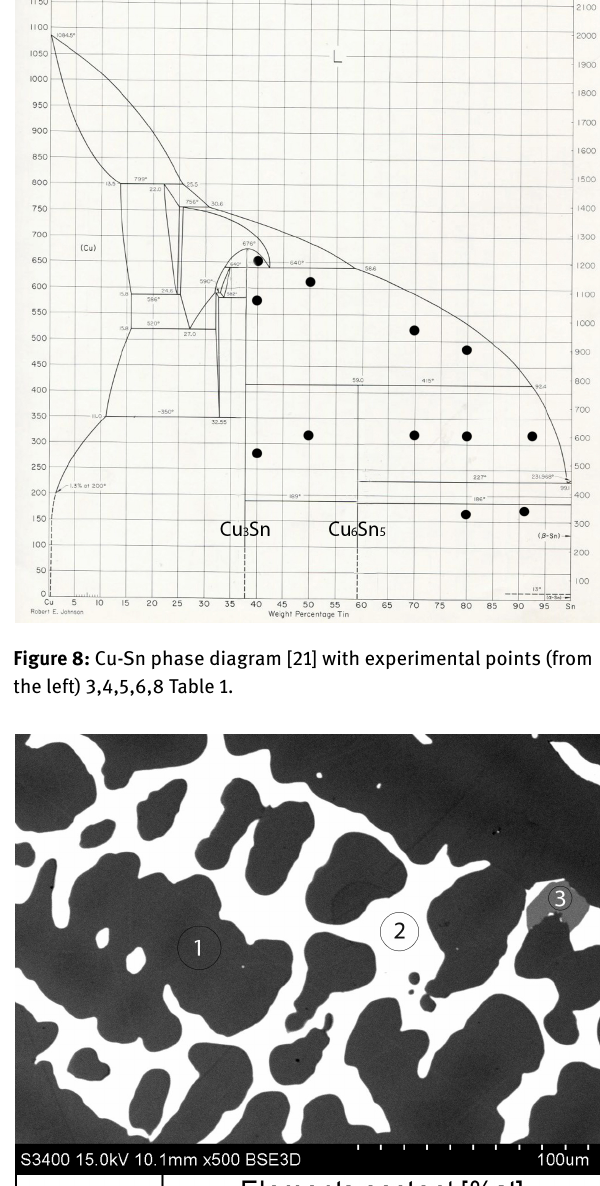
are the evidence of transition from ((Cu6Sn5) + liquid) to (Cu6Sn5) + Sn. Values of the enthalpy of melting ∆ H M are higher for alloys of higher Cu concentration, and